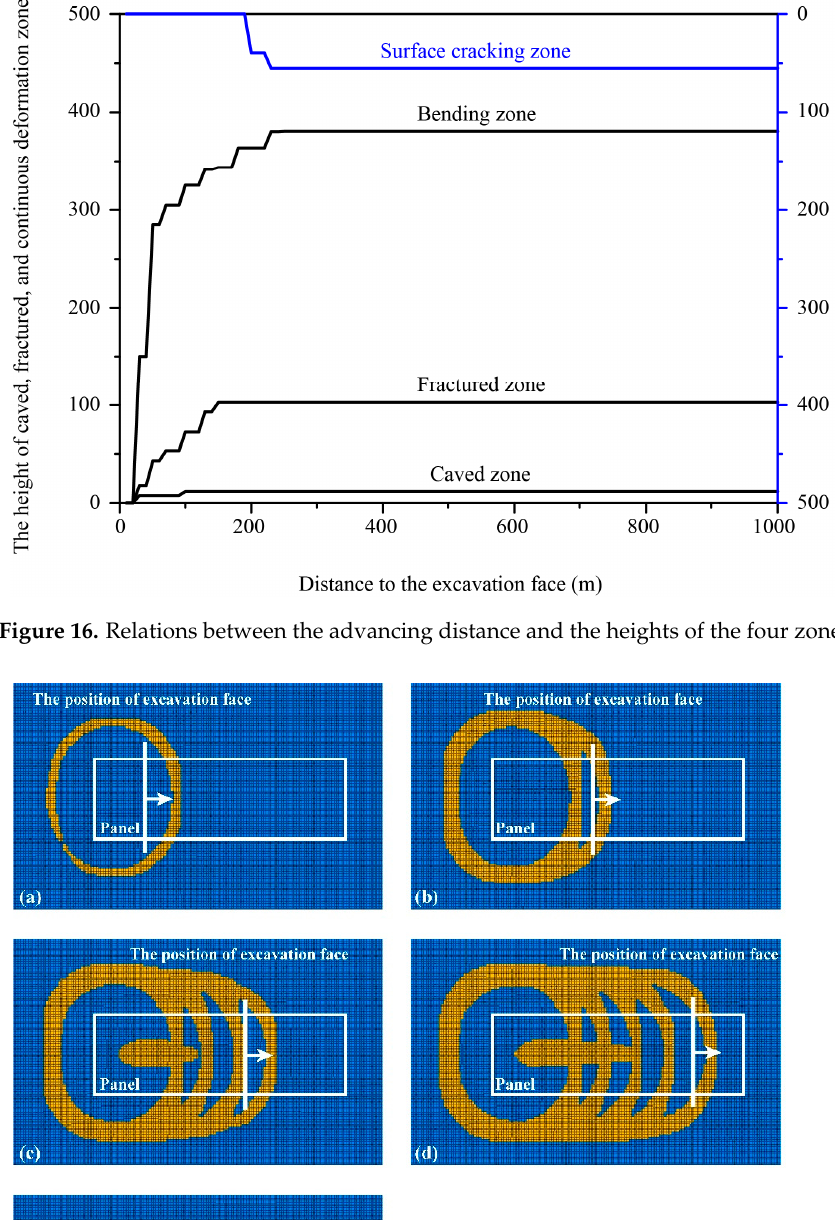
Figure 15. Evolution laws of the four zones due to excavation (200 m, 400 m, 600 m, 800 m, and 1000 m).